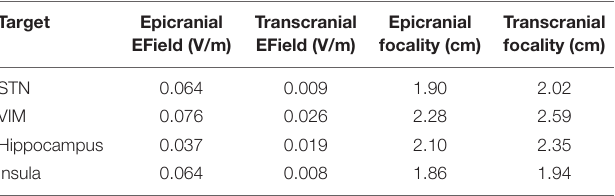
TABLE 1 | Comparing the results of interferential stimulation (IF) using epicranial cortical stimulation (ECS) to that using transcranial electric stimulation (TES). Target